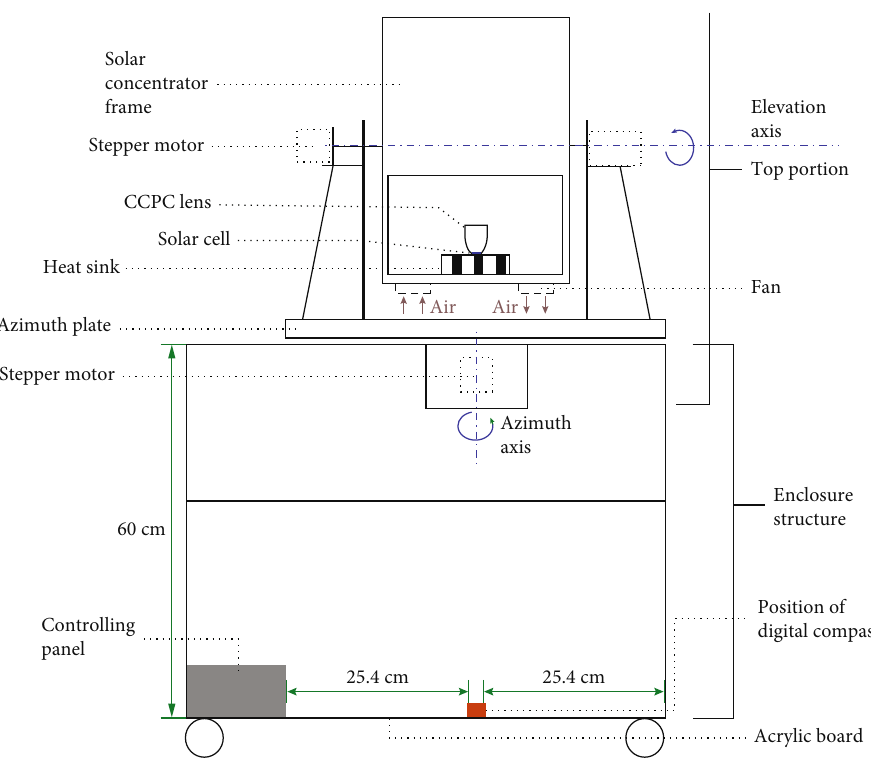
Figure 4: Schematic diagram of the prototype mobile sun-tracking (MST)